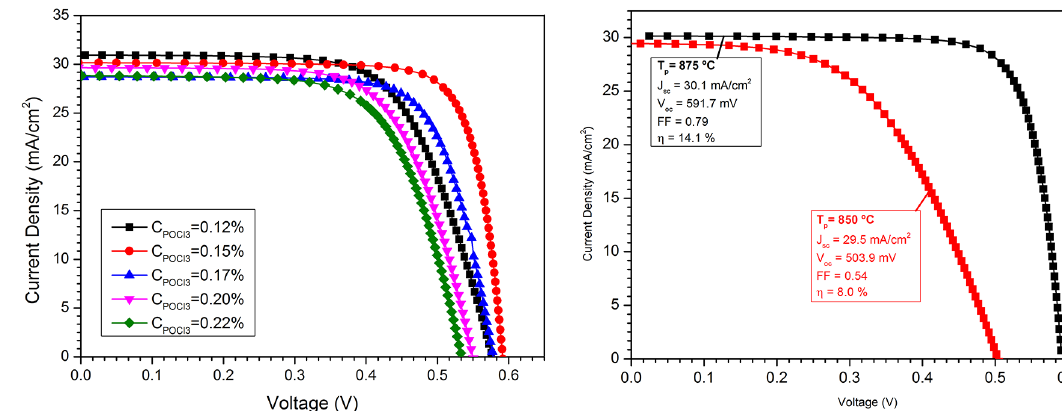
Figure 3. J-V curve of the solar cells with the highest efficiency, processed with the phosphorus temperature diffusion of 850 ºC and 875